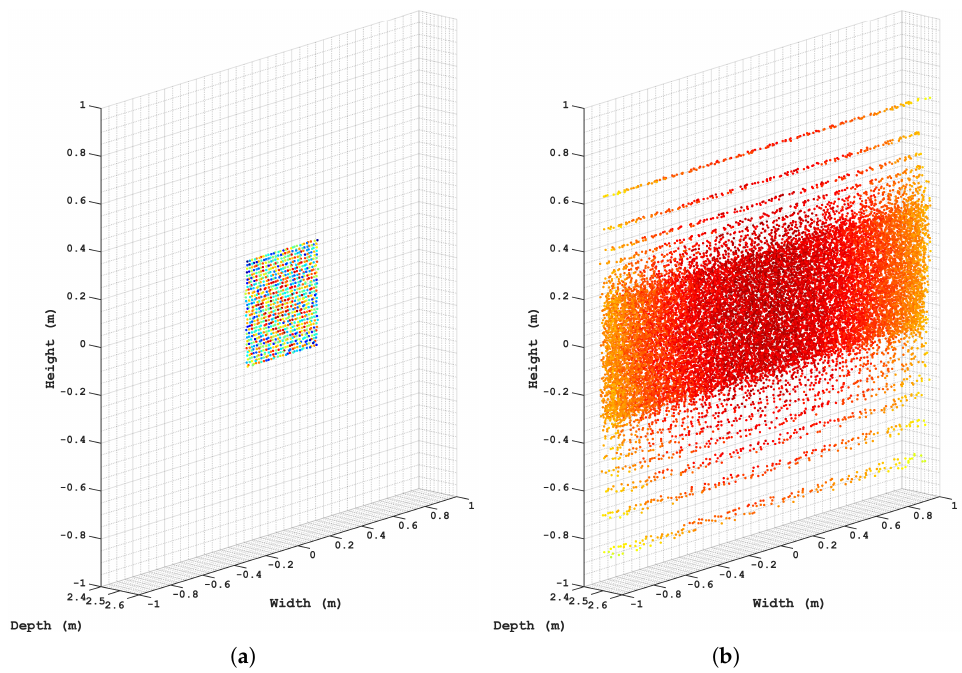
Figure 11. 3D point cloud generated by the LIDAR scanners. ( a ) Sequential firing LIDAR scanner.